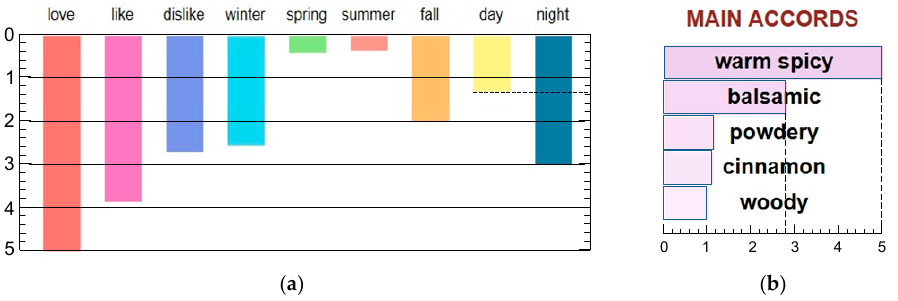
Figure 1. Olfactory profiles of the fragrance Cinnabar according to Fragrantica’s website. ( a ) Preference profile obtained from consumers. On the vertical scale (established from 0 to 5), day = 1.35 and night = 3, which leads to the percentages: day = 1.35/4.35 = 31%, night = 100% − 31% = 69%. Seasonal percentages were obtained analogously. ( b ) Description of main accords on a 0–5 scale (the maximum value corresponds to the most noticeable